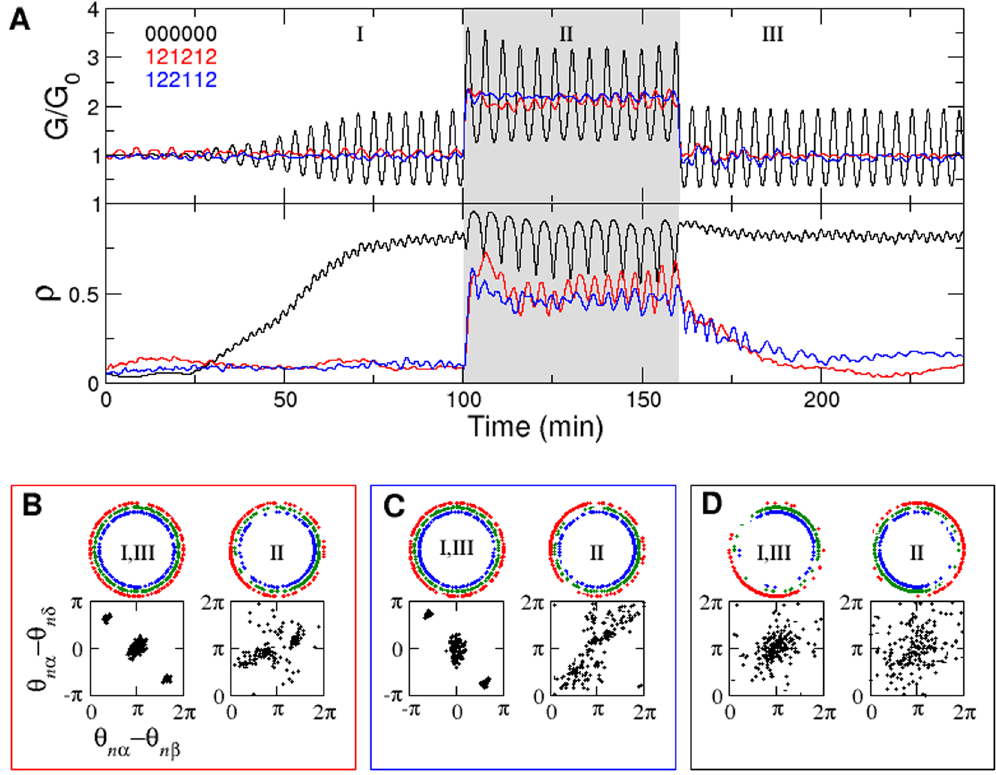
Figure 3. Controllable inter-islet synchronization and phase coordination between islet cells. ( A ) Glucose regulation and inter-islet synchronization for networks 121212 (red), 122112 (blue) and 000000 (black), given the external glucose input ( I = 2 G 0 ) during 100 < t < 160. Phase snapshots of α , β , and δ cells under different glucose conditions (regimes I, II, and III) for ( B ) networks 121212, ( C ) 122112, and ( D ) 000000. Upper panel: absolute phases ( θ n α , θ n β , α (red), β (green), and δ (blue) cells in the pancreas consisting of 200 islets. Lower panel: phase differences θ n δ ) of ( θ n α − θ n β , θ n α − θ n δ ). The axis range was adjusted to show distinct attractors considering 2 π